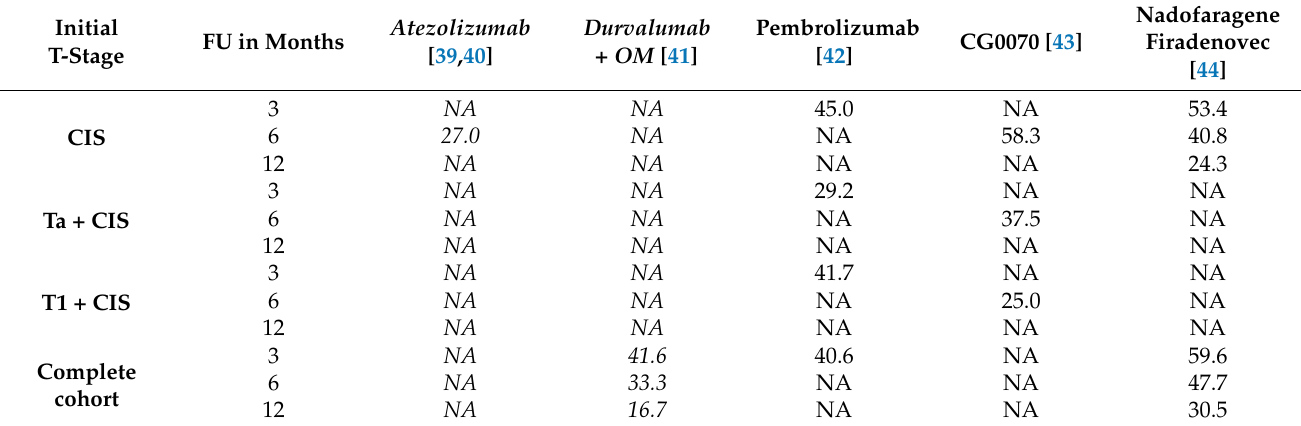
Table 2. Rate of CR in percentage terms according to initial T-stage (NA = not available).